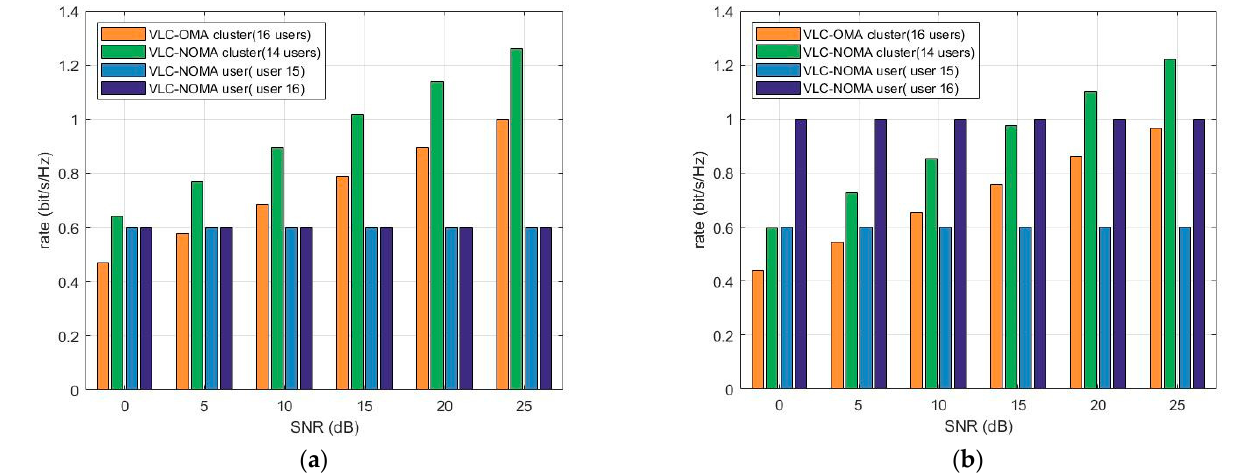
Figure 5. ( a ) Rates of different users under the same QoS. ( b ) Rates of different users under different QoS.